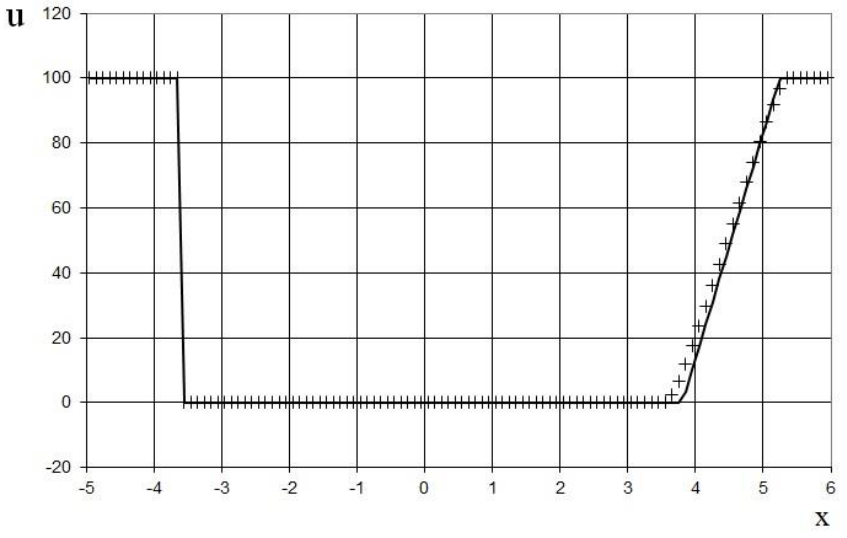
Figure 27. Velocity plot for the problem (53): the exact solution (line), and the present method (cross).